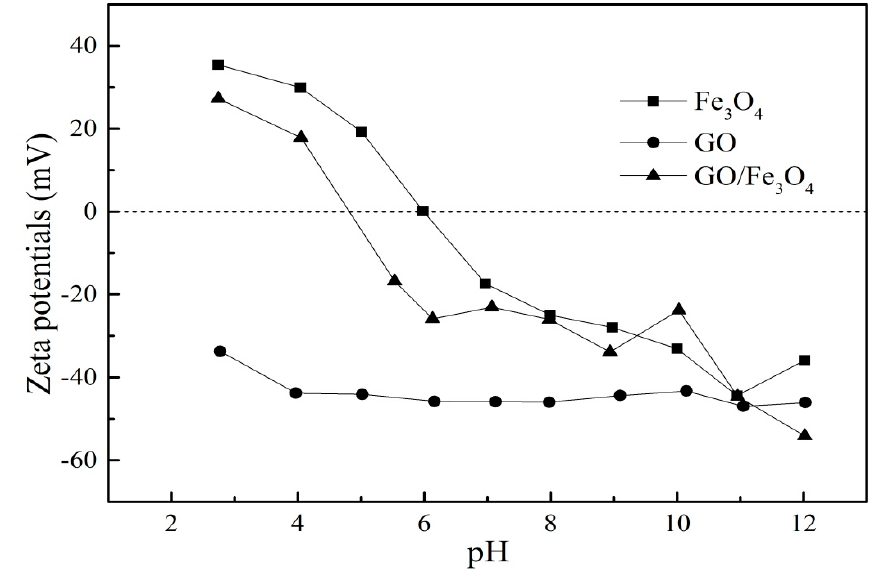
Figure 5. Zeta potential of GO, Fe 3 O 4 , and GO/Fe 3 O 4 .